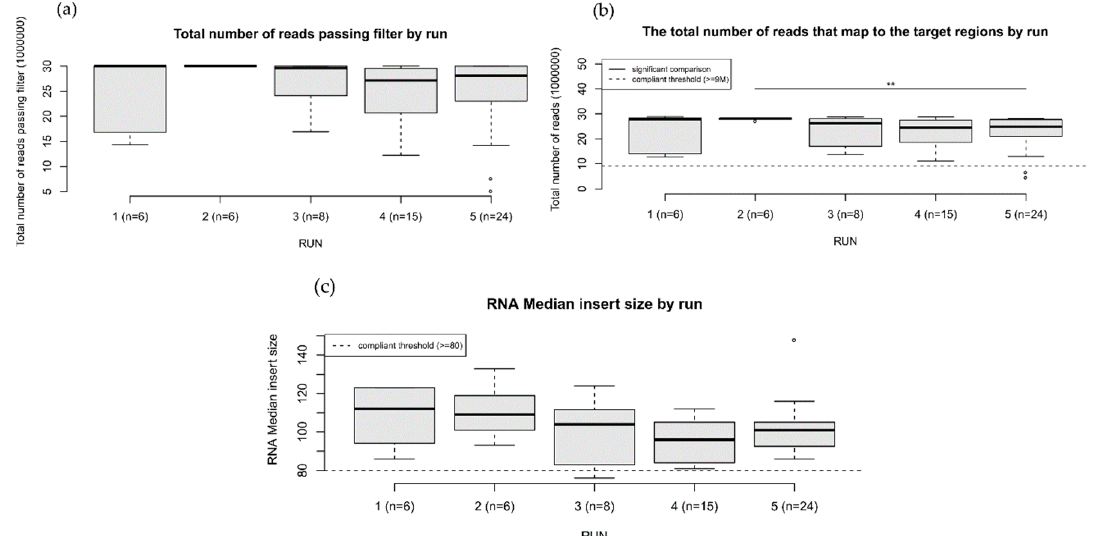
Figure 3. RNA sequencing quality metrics over 59 samples. Each boxplot shows the metrics distribution for the five runs. Pairwise comparisons between runs were done through a two-sided Wilcoxon rank-sum test ( p -value: ** p < 0.01). ( a ) Total number of reads passing (quality score > 30). ( b ) Total number of reads mapping to the target regions. ( c ) Mean read length (bp) by run.